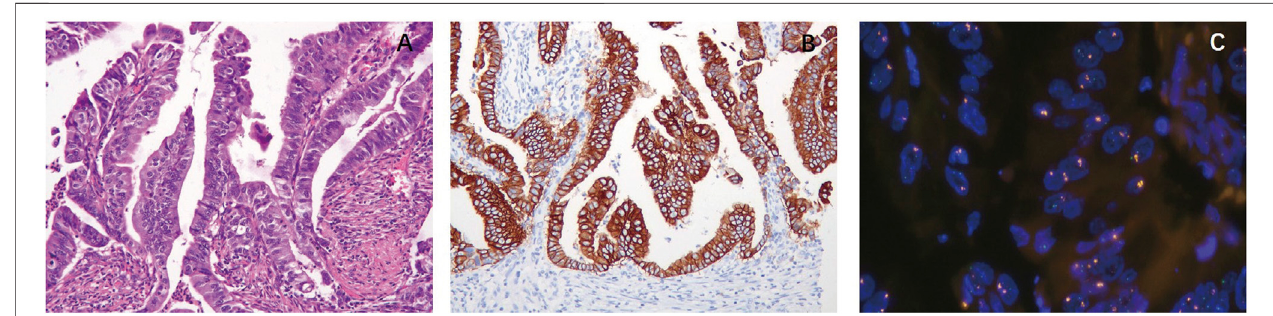
FIGURE1| CorrelationbetweenmorphologyandHER2 expression and ampli fi cation. (A) Papillary adenocarcinoma (HE,×20). Thepresence ofpapillarystructure in adenocarcinoma (AC) was associated with HER2 positivity. (B) Papillary adenocarcinoma. HER2 immunohistochemistry (IHC) score of 3+ shows strong complete membranous reactivity in all tumor cells. (C) Papillary adenocarcinoma. Tumor cells exhibited HER2 ampli fi cation.